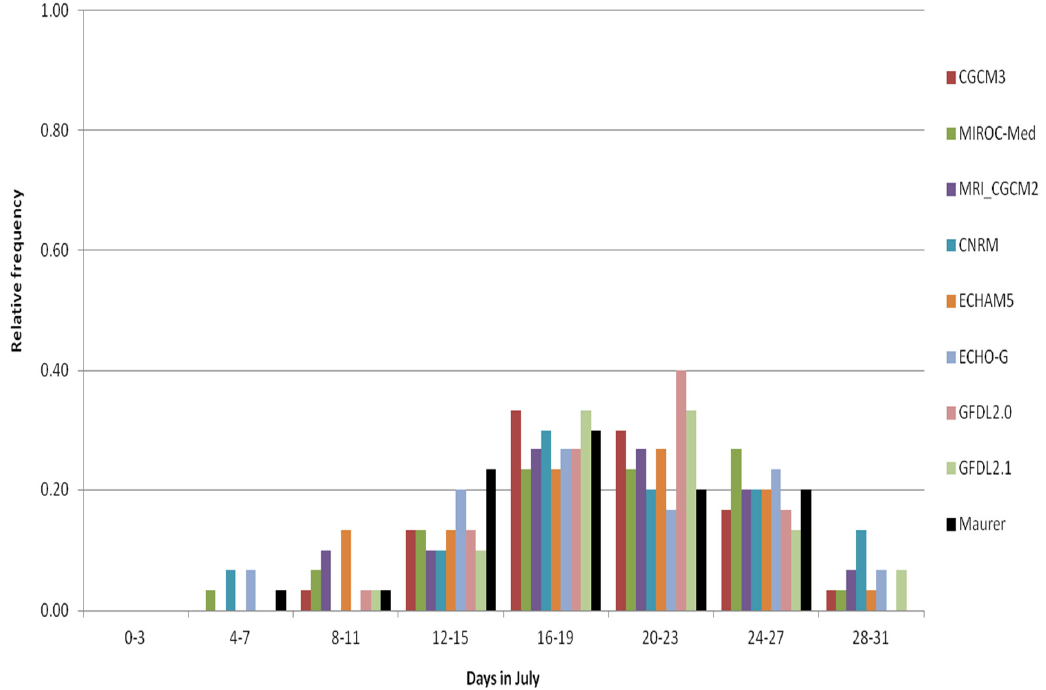
Figure 6. Histogram of HD30 in July, 1971–2000, Washington DC area, as represented by the Figure Maurer02v2_1/8 observed data and the individual BCCA downscaled GCM time series (BCCA_ensemble_1/8).